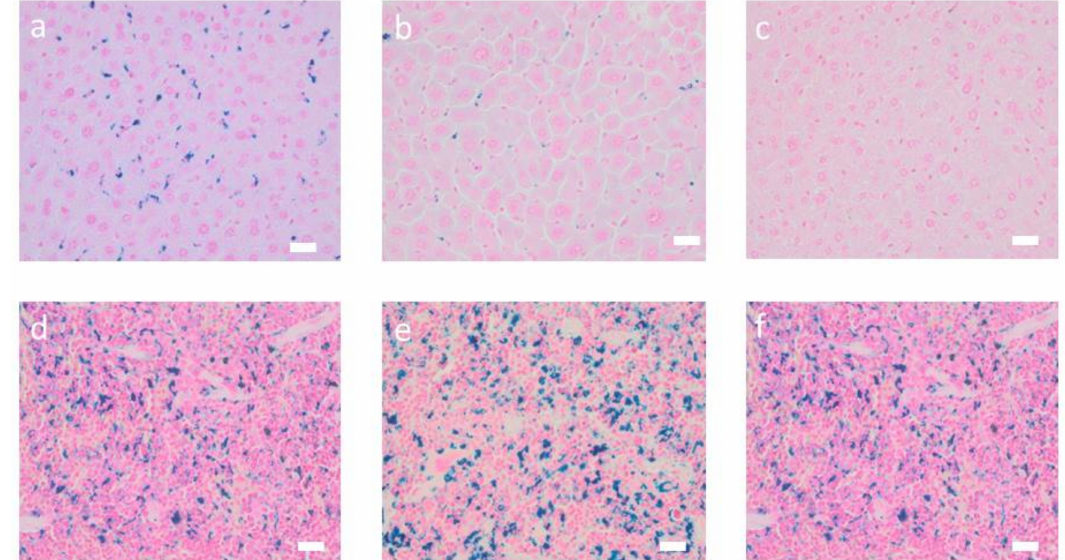
Figure 3. Animals injected with MNP-D(DY-730)-PEG-5kDa(DY-555) show distinct iron depositions in liver and spleen. Iron oxide deposits in Kup ff er cells of the liver and hepatocytes ( a – c ) and spleen ( d – f ) of mice injected with MNP-D(DY-730)-PEG-5kDa(DY-555), 200 µ mol Fe / KG body weight. ( a , d ): 0 months; ( b , e ): 2 months after MNP injection; ( c , f ): non-MNP injected animals. Prussian blue staining of liver and spleen tissue. Bars: 20 µ